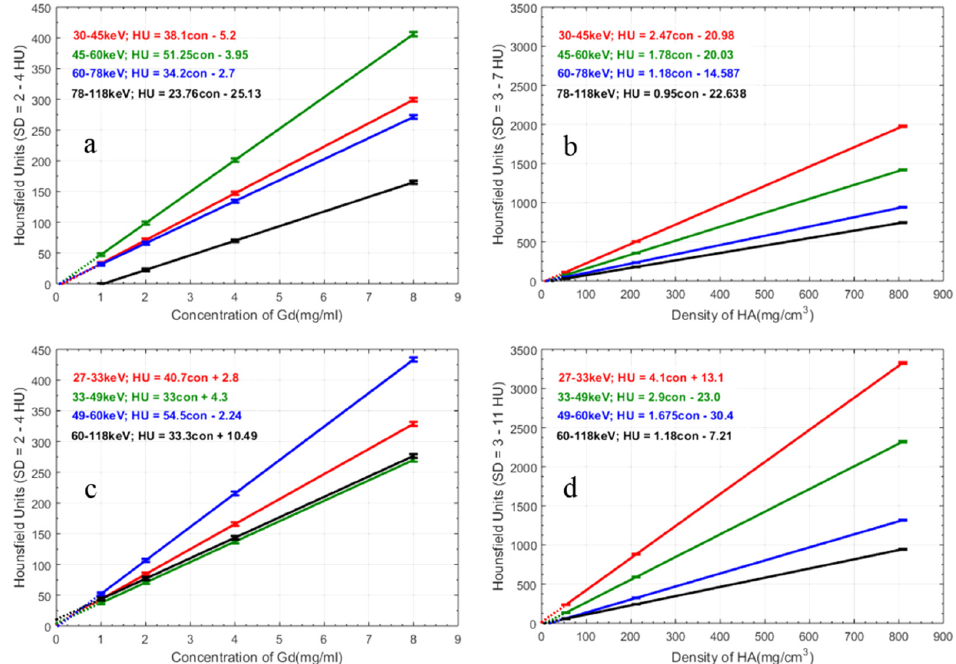
Figure 7. HU as a function of the concentration of gadolinium and hydroxyapatite with protocol ‐ 1 ( a , b ) and protocol ‐ 2 ( c , d ). The linear fitted lines for both materials indicate average correlation coefficient of ≥ 0.99 for all four energy bins.